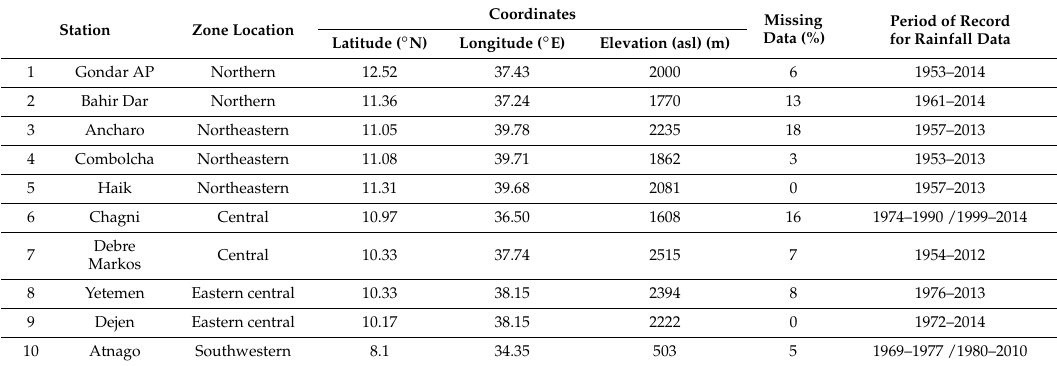
Table 1. Geographic characteristics of the rainfall stations and descriptive statistics for the rainfall data time.